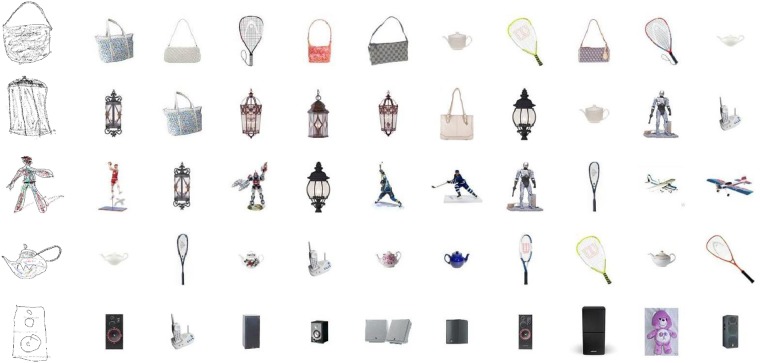
Retrieval performance on other categories.